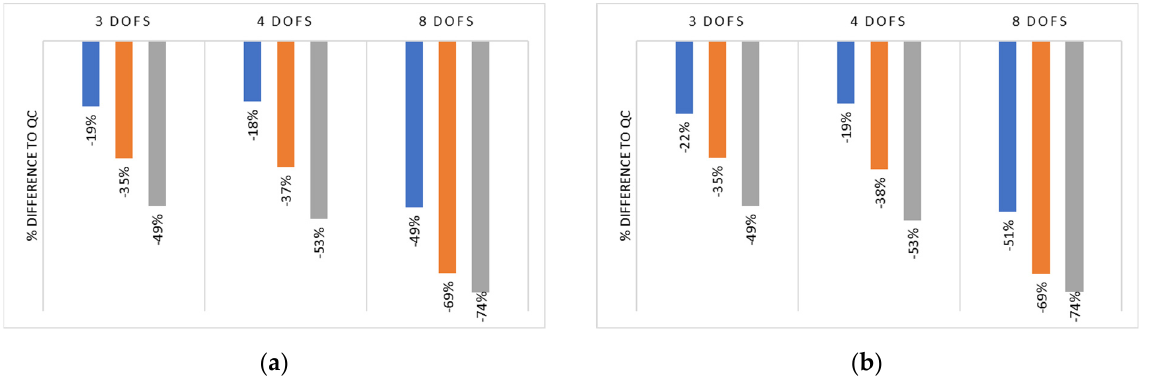
Figure 14. The percent difference in the VDV of the top DOF for every model to the peak value of the acceleration of the top DOF of the QC model for the ( a ) bump and the ( b ) pothole excitation (blue = 5 km/h, orange = 10 km/h and grey = 15 km/h).